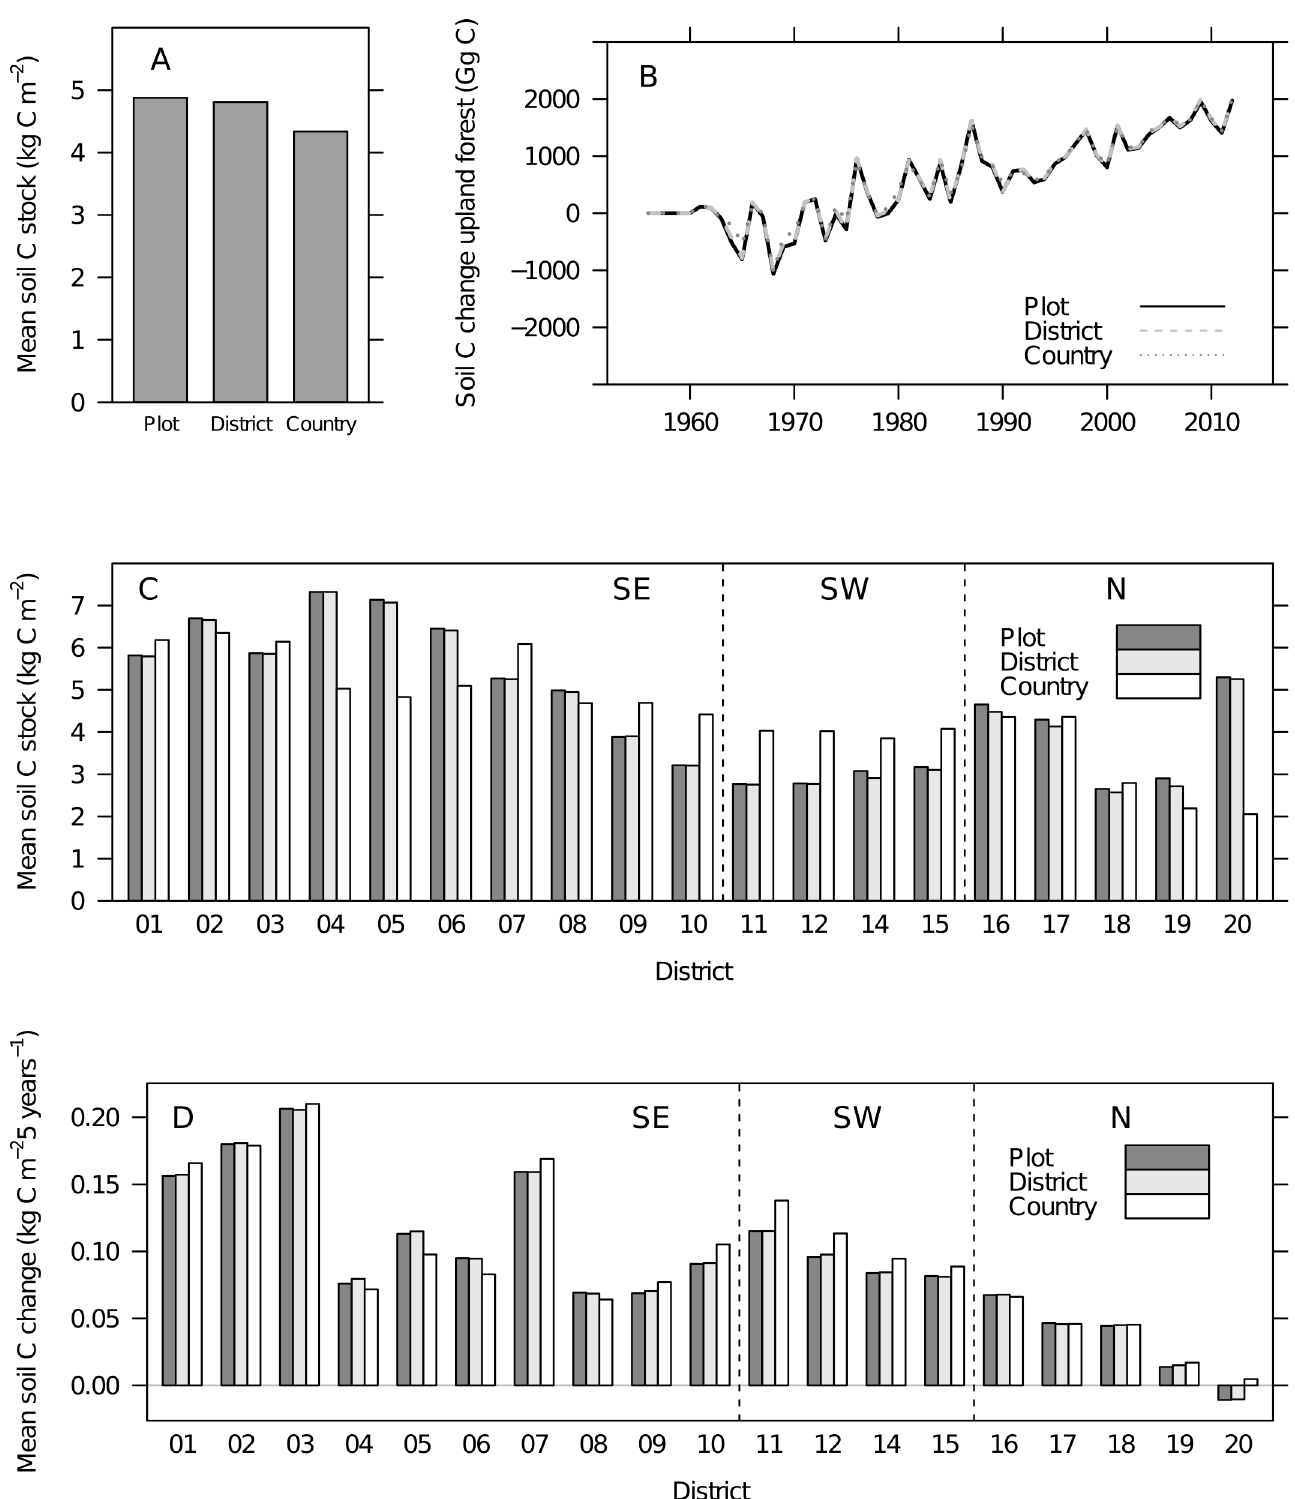
Fig 3. Soil carbon stocks and changes using Yasso07 and Norwegian NFI data – effects of spatial aggregation. All the simulations shown used constant mean climate for 1961 – 1990 and 1991 – 2008 for spin-up and time series calculations, respectively. Simulations differed by representing three levels of spatial aggregation: plot- (n = 11275), district- (n = 19) and country-scale. Vertical lines (figure parts C and D) indicate distribution of districts to regions